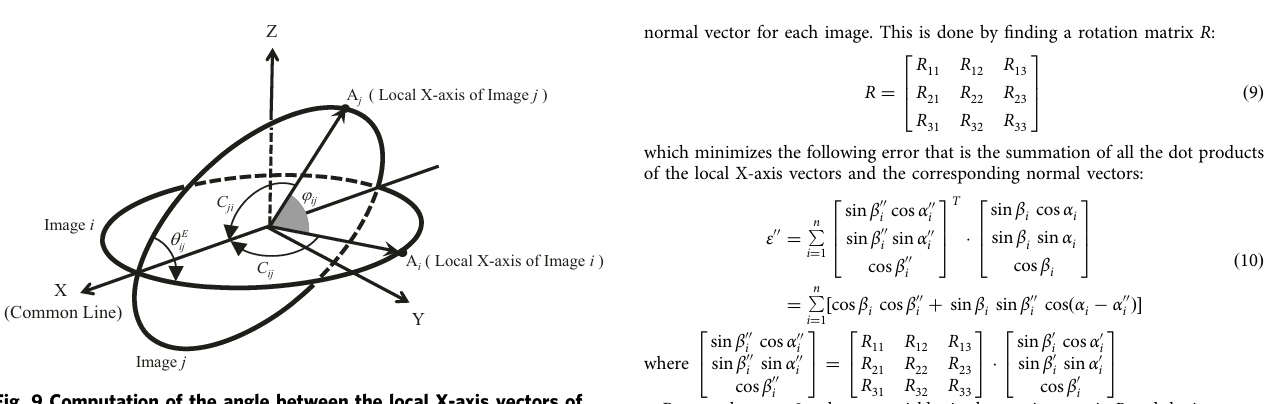
Fig. 9 Computation of the angle between the local X-axis vectors of image i and image j . Image i is on the XY plane. The common line between image i and image j is